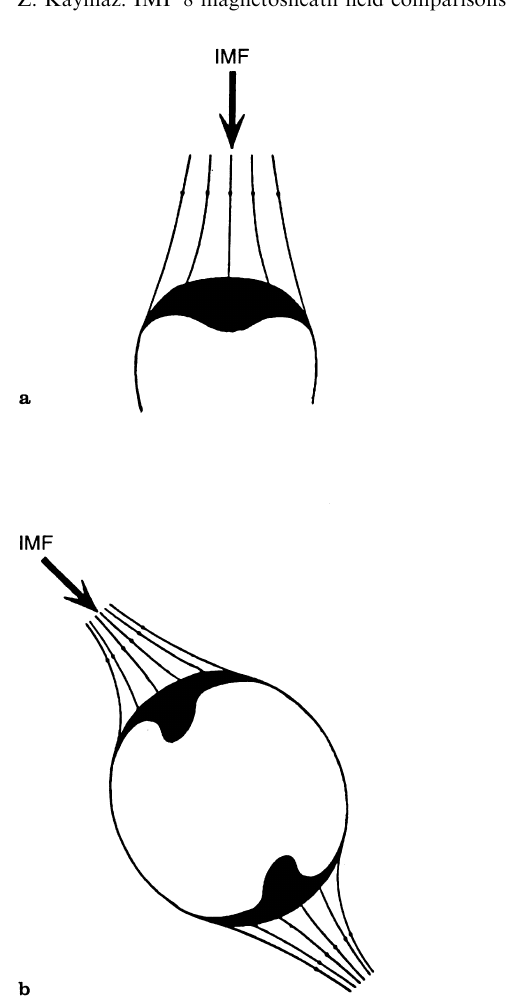
Fig. 3a, b. A phenomenological model of the open magnetosphere from Siscoe and Sanchez (1987) showing magnetospheric ‘‘windows’’, where the magnetosheath field lines interconnect with the geomag- netic field lines, for a southward IMF and b southward IMF with a non-zero B